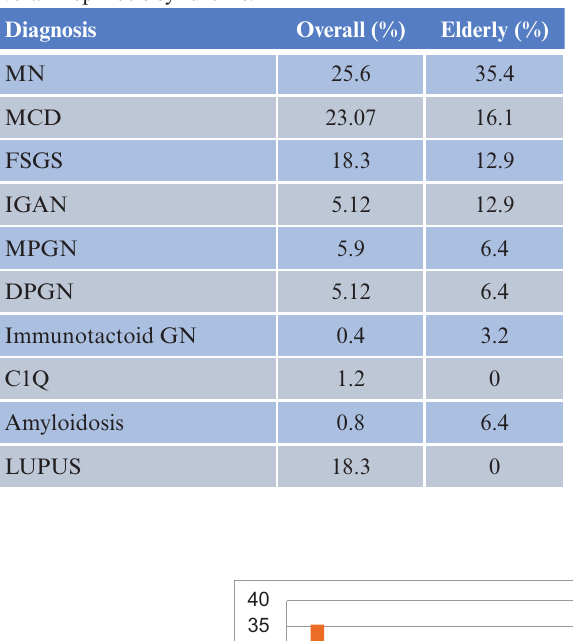
Table 4: Comparison of the biopsy spectrum of elderly and overall nephrotic syndrome.